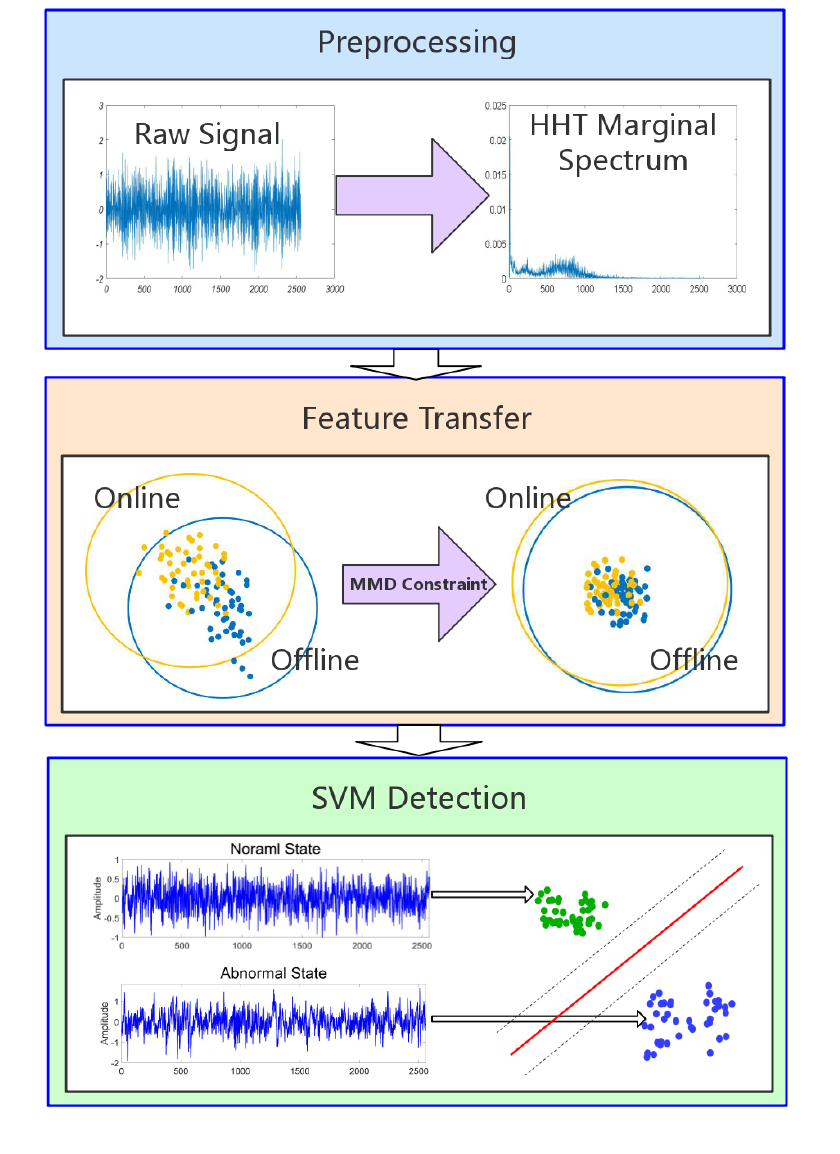
Figure 5. Flow chart of online detection for early